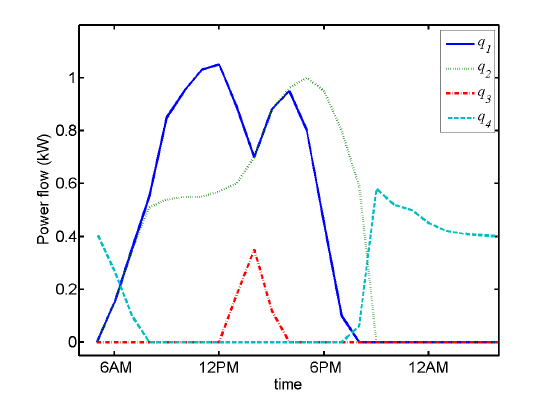
Figure 11. Flows in the power network illustrating the viability of the continuous logic